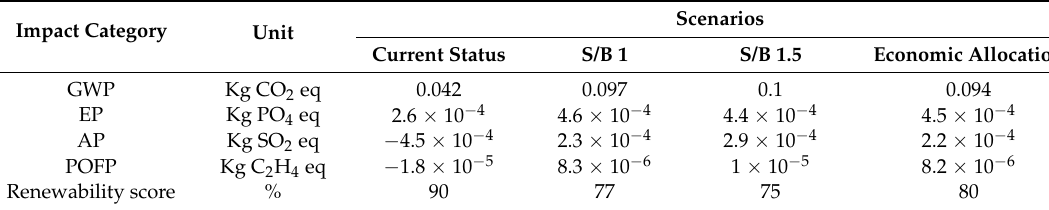
Table 11. Comparison of different scenarios.